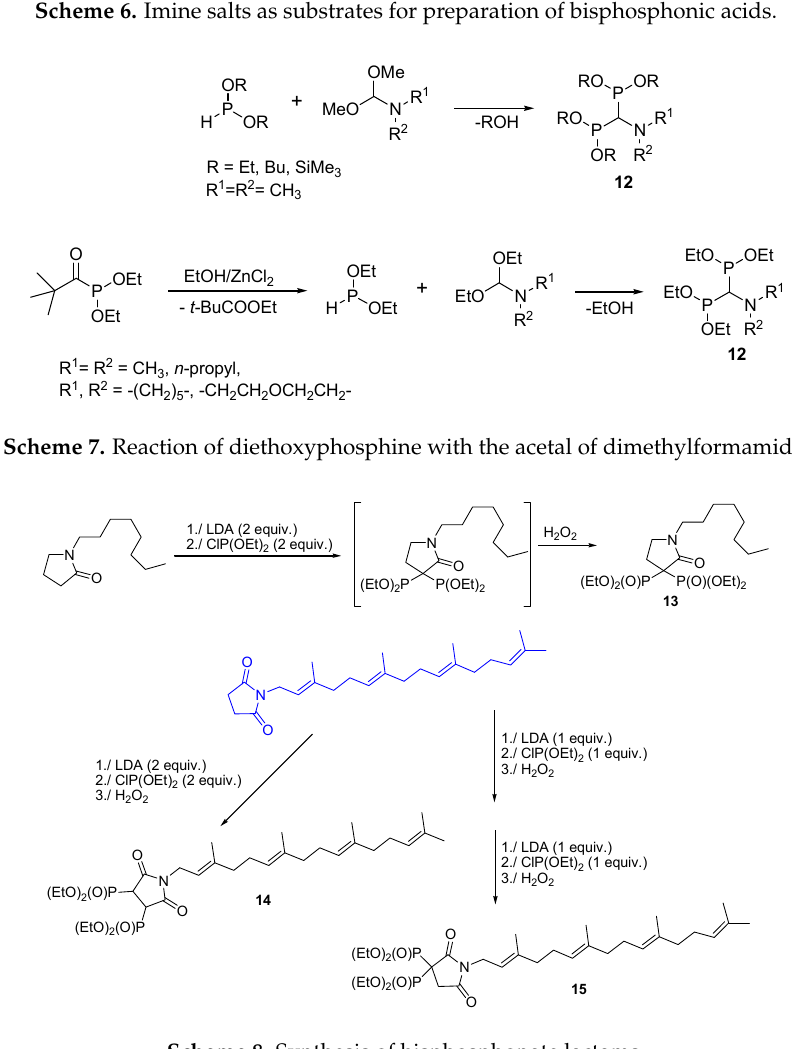
Scheme 8. Synthesis of bisphosphonate lactams.